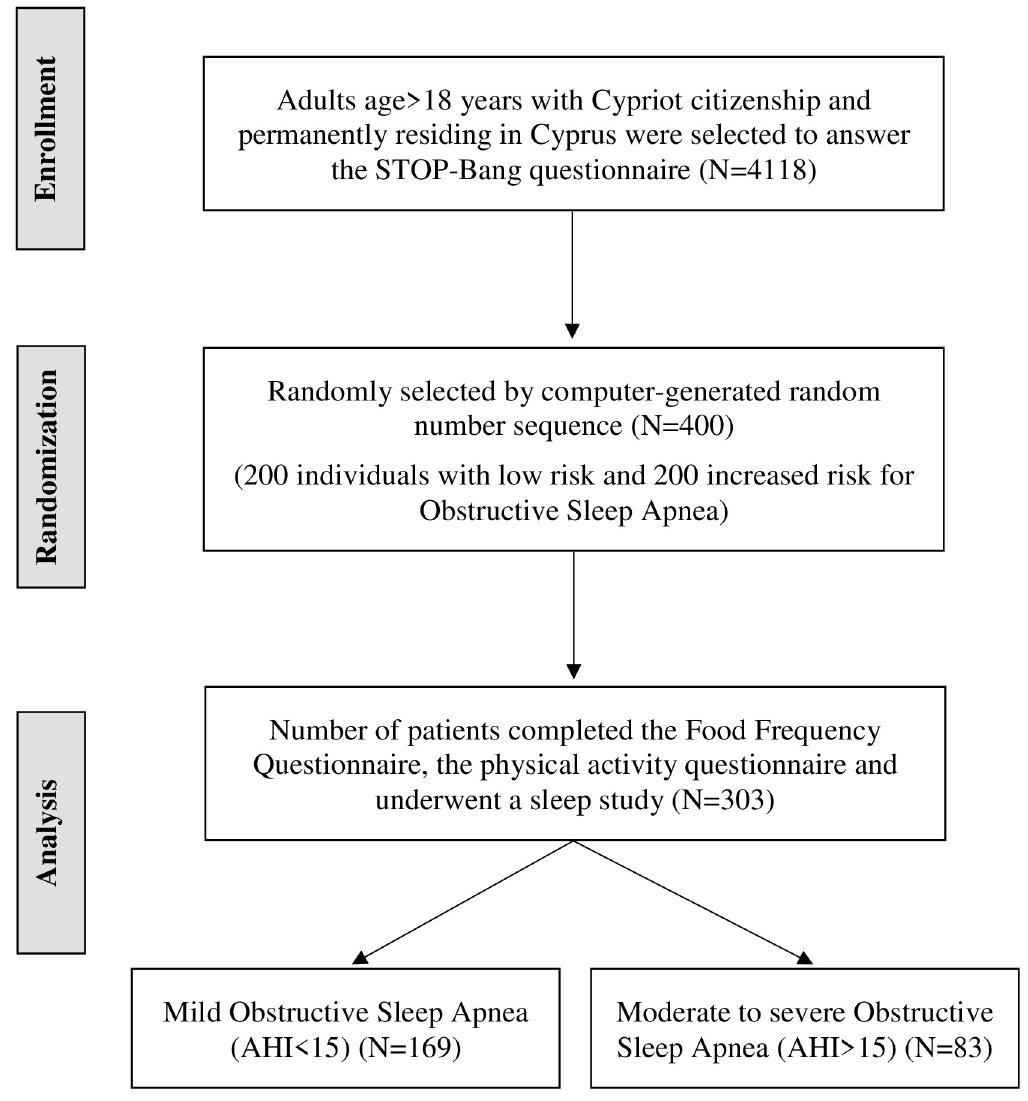
Fig 1. Study selection flow